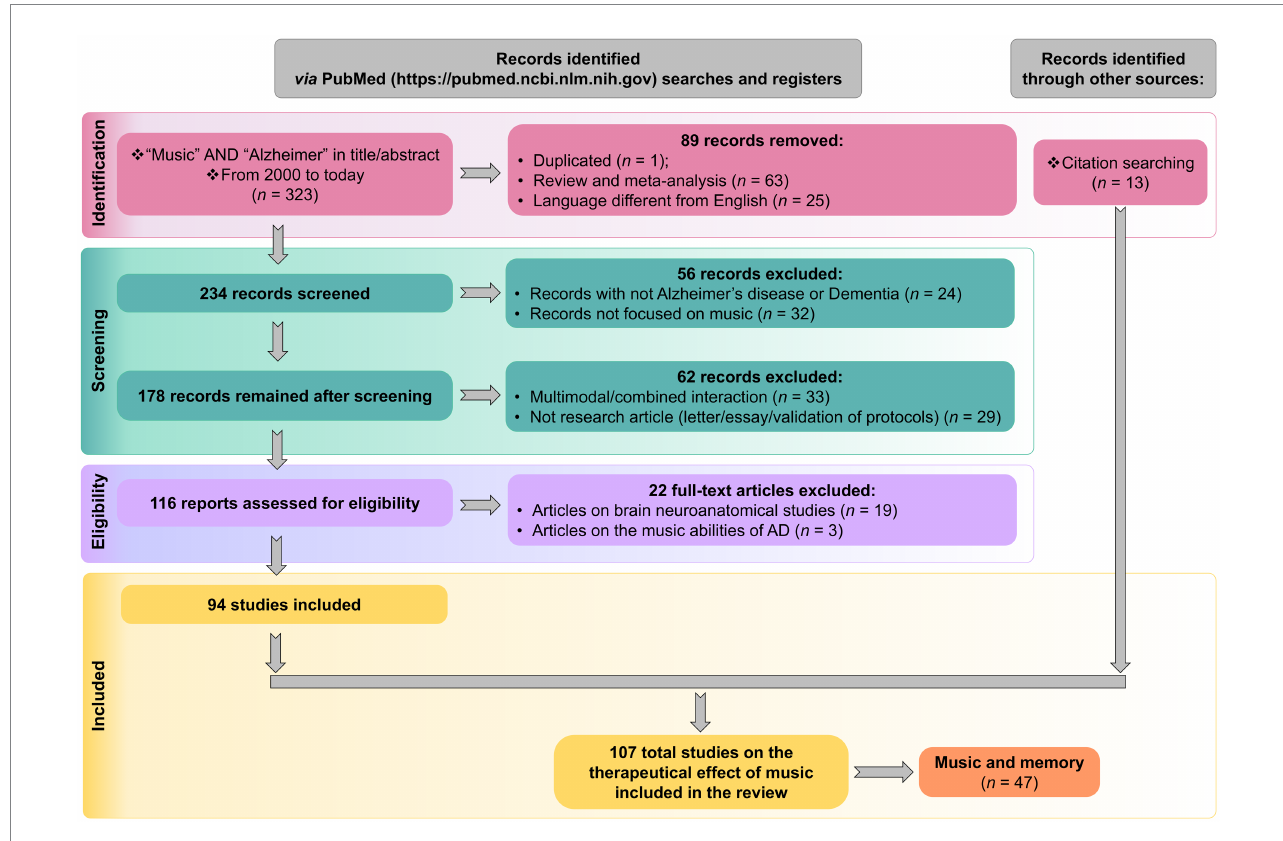
FIGURE 1 The systematical review adhered to PRISMA guidelines and following the flow diagram described in the